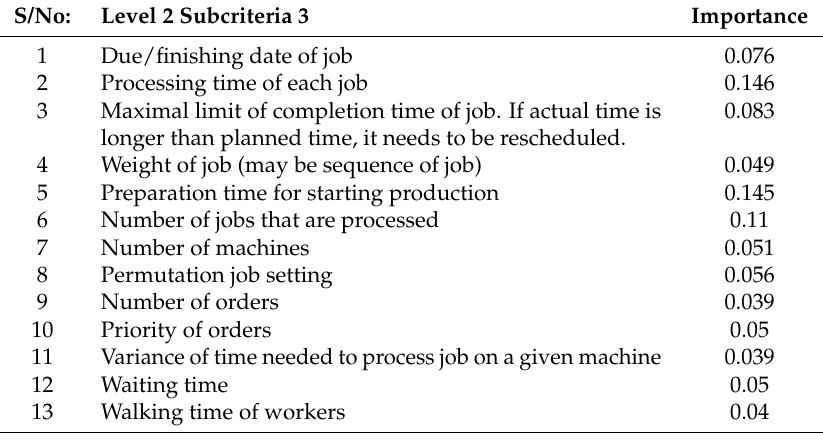
Table 7. Level 2—subcriteria